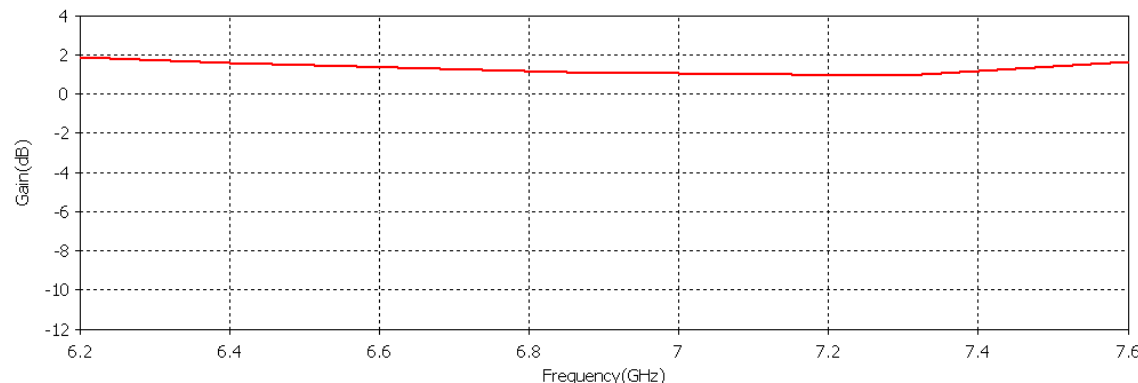
Figure 7. Variation of gain as a function of frequency for modified geometry with elliptical slot in patch